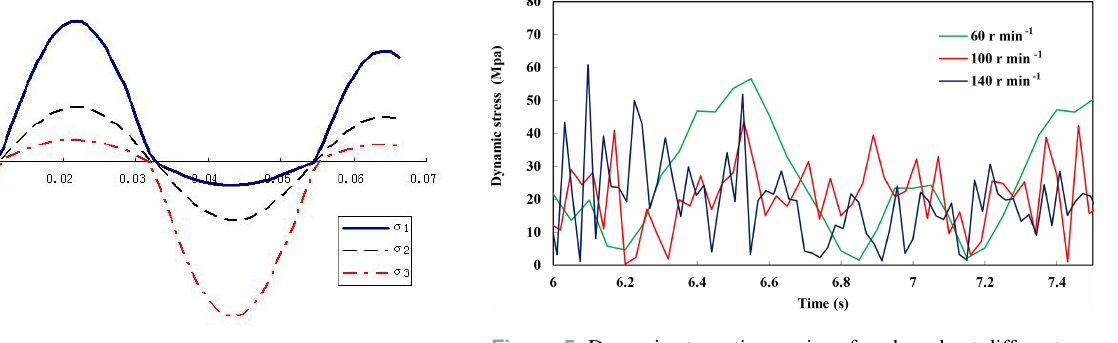
Figure 5. Dynamic stress time series of each node at different ro- tary